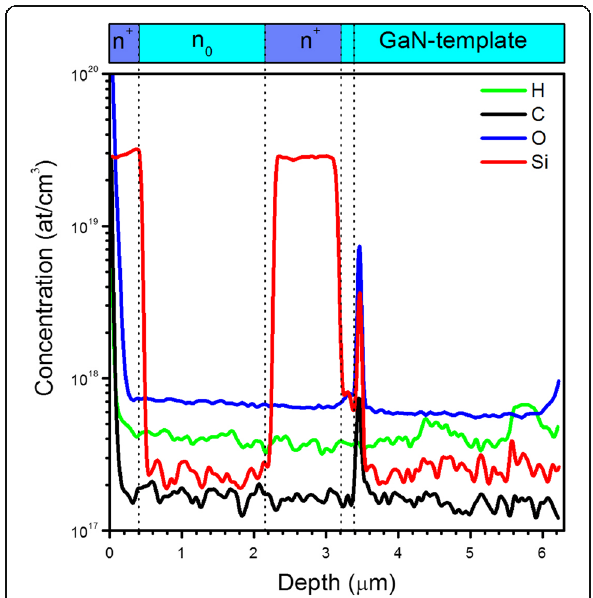
Fig. 3 Impurity elements profiles of the investigated n + /n 0 /n + -GaN structure measured by SIMS from the sample